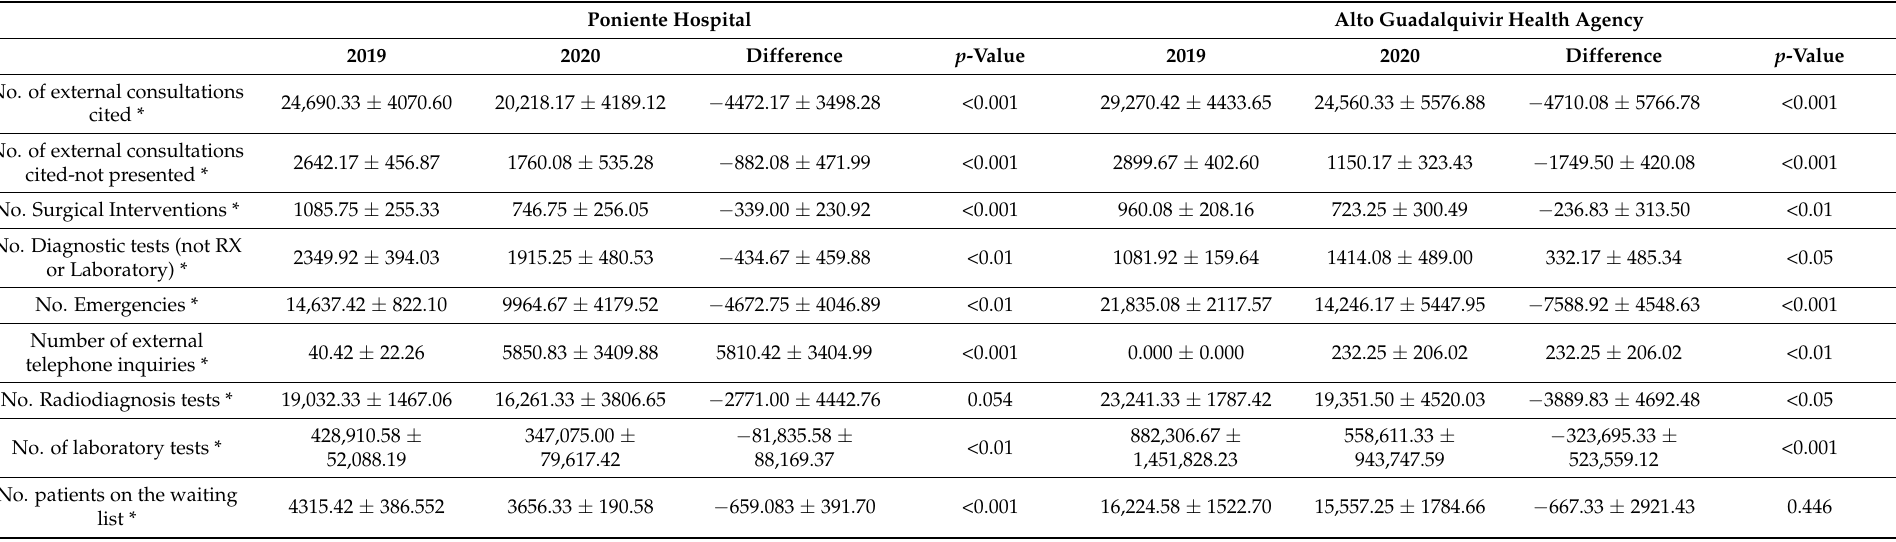
Table 2. Main results of the healthcare activity carried out in both healthcare institutions pre- and during the first year of the